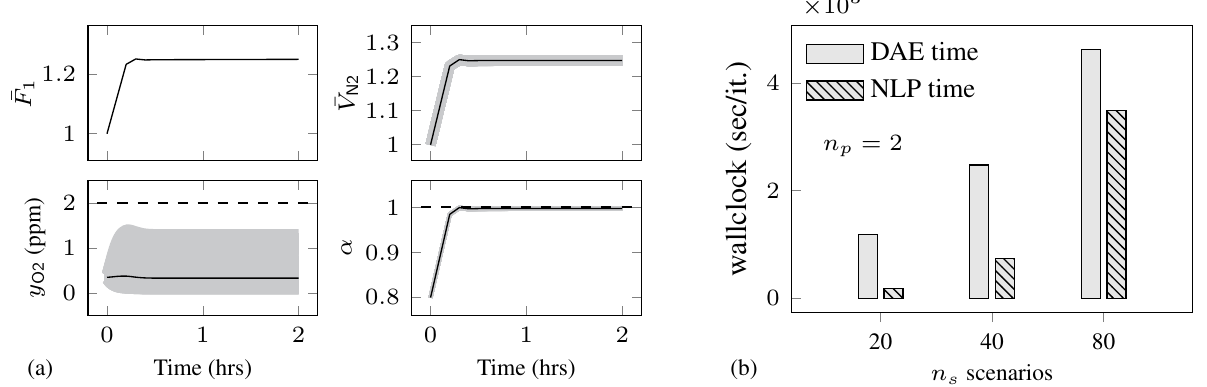
Figure 5. Case Study 2: ( a ) robust control and select output trajectories (nominal solution represented by the solid line) and ( b ) base line DAE and NLP solution times for increasing n